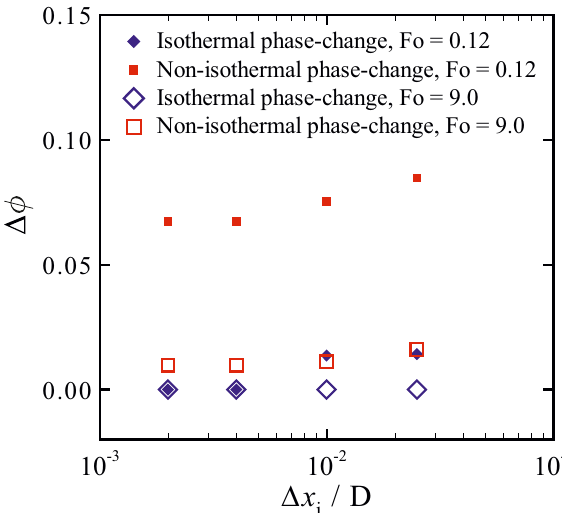
Figure 7. The relative difference between liquid fractions predicted with different permeability coefficients (i.e., C 1 = 1 × 10 8 kgs − 1 m − 3 and C 2 = 1 × 10 4 kgs − 1 m − 3 ) on different grid densities. Diamonds (in blue): isothermal phase-change; squares (in red): non-isothermal phase-change; unfilled symbols: Fo = 9.0 (steady-state condition); filled symbols: Fo =